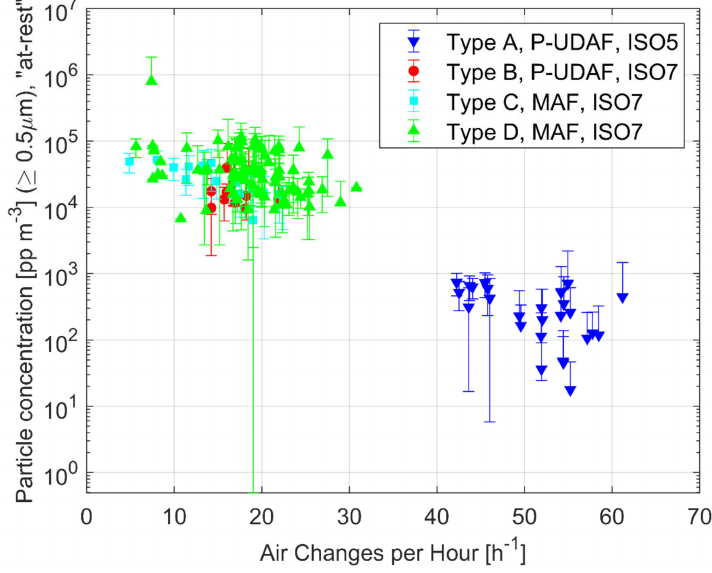
Figure1. Averageairborneparticleconcentrationvs. ACHin“at-rest”conditionsforthe175investigated OTs. Cumulated values for particles ≥ 0.5 µ